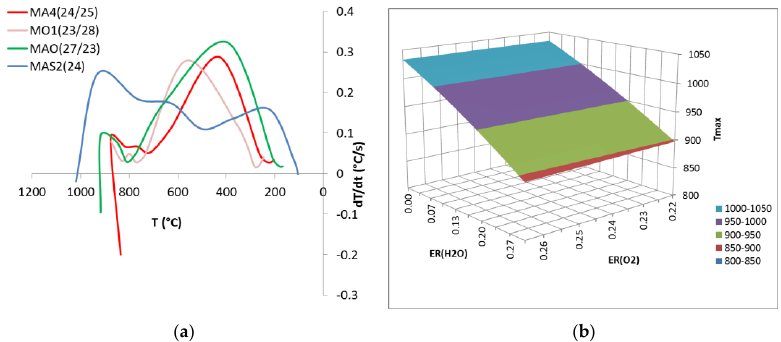
Figure 5. Thermal profile inside the gasifier in the gasification of almond shells (M): ( a ) Thermal gradients; ( b ) 3D plot of the maximum temperature in the bed.